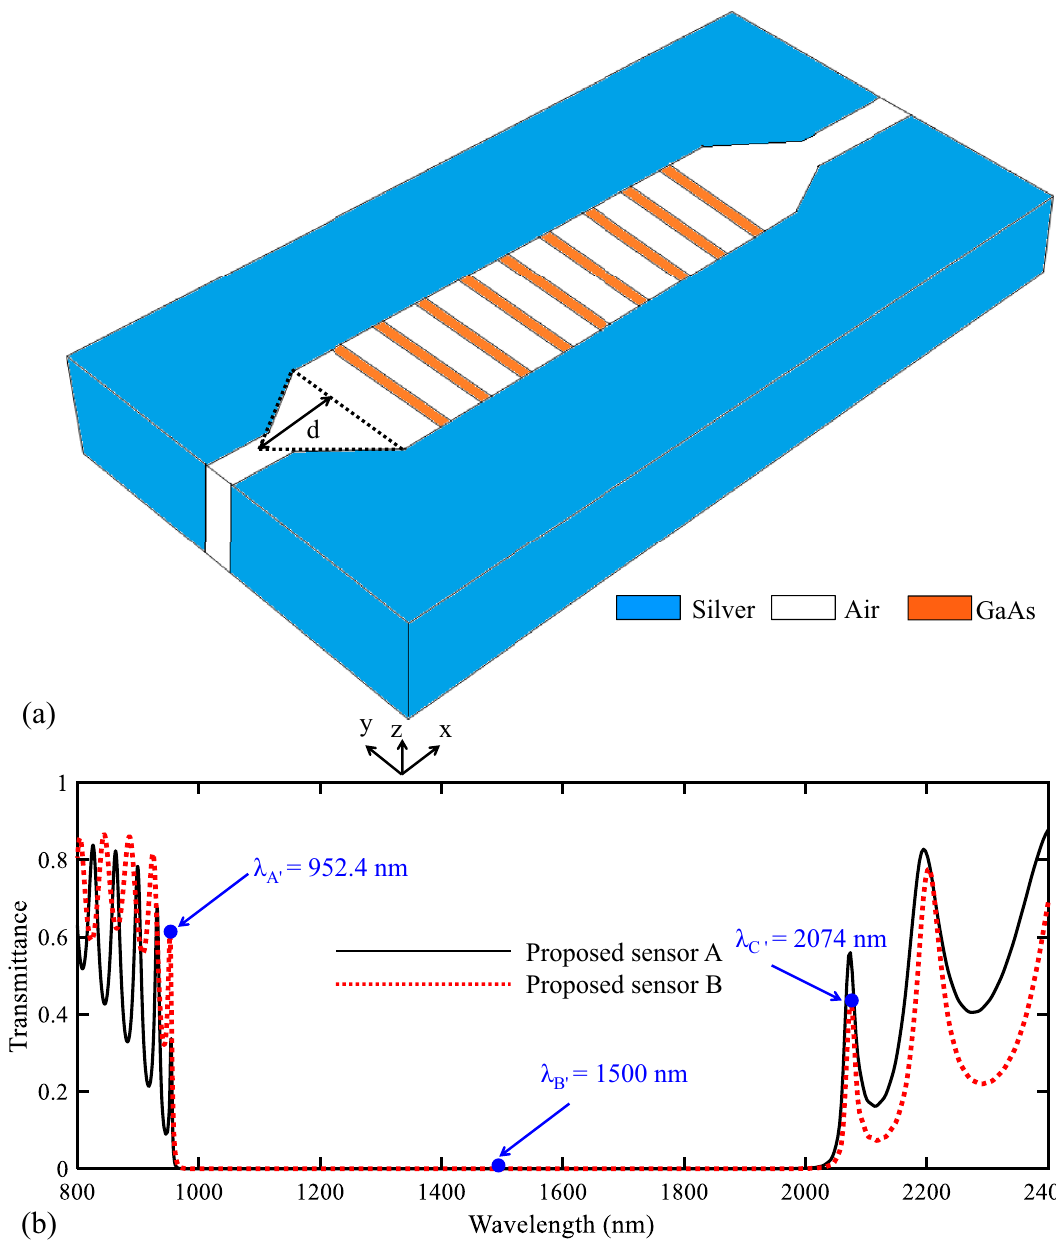
Figure 11. ( a ) 3D topology of the proposed biosensor II. ( b ) Transmission spectra of the proposed biosensor I and biosensor